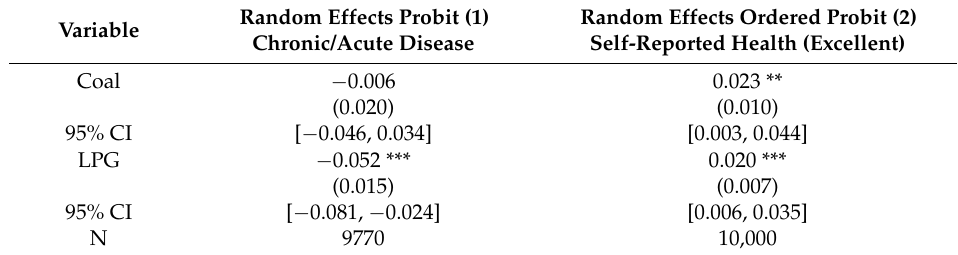
Table 4. Random effects (ordered) probit estimates for the effect of household cooking fuels on women’s health in rural areas: CFPS